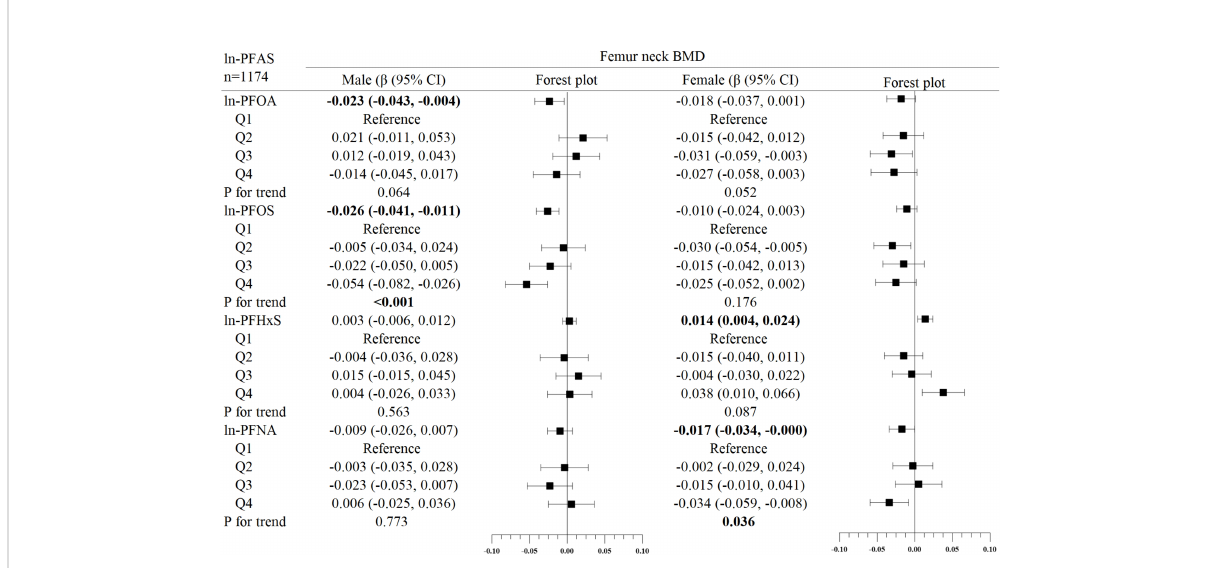
FIGURE 3 Association between ln-PFOS and bone mineral density, strati fi ed by gender. Adjusted for age, race, income poverty ratio, serum cotinine, vigorous physical activity, moderate physical activity, BMI, serum lead, albuminuria, and anemia. The bold values indicate signi fi cance